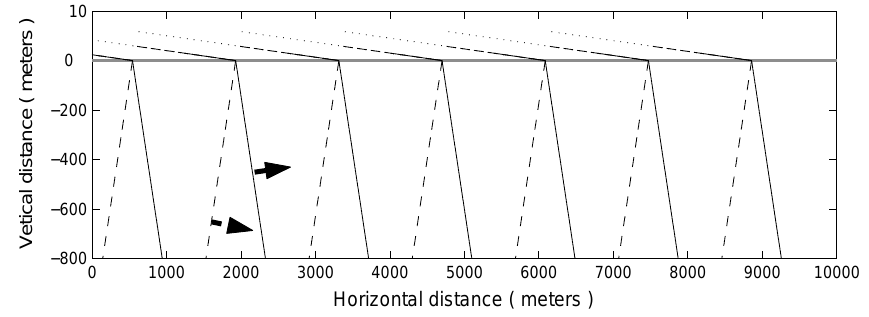
Fig. 13. Sketch illustrating the geometry of the generation of evanescent viscosity waves (above the gray line) by partially reflected acoustic waves (below the gray line). Solid and dashed lines in the lower part indicate wave fronts of the incident and reflected waves, respectively. In the upper part, wave fronts of the evanescent waves are indicated as solid lines, changing to dashed and then to dotted lines at increasing distances above the reflecting level, to indicate the rapid attenuation of the wave amplitudes in these evanescent waves. The scales are appropriate for an incident infrasonic wave of 5-s period producing evanescent waves with a wavelength of 3m. Note that the vertical scale is not the same above and below the reflecting level (gray